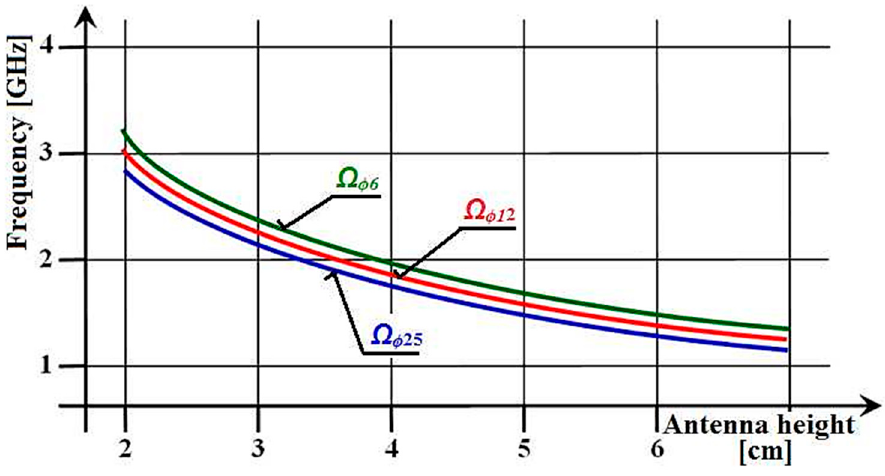
Figure 7. The graphical course of resonant frequencies depending on the slenderness of the dipole.